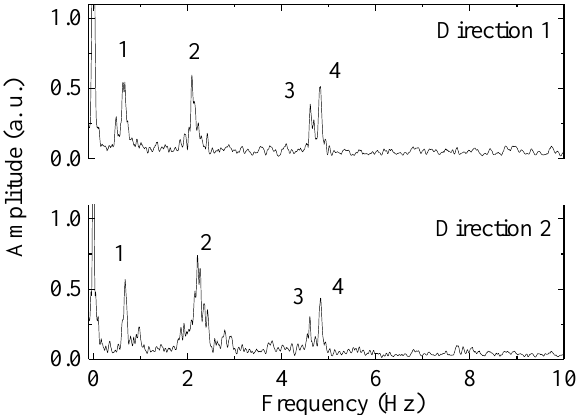
Figure 8. Radio communications tower frequencies spectra.